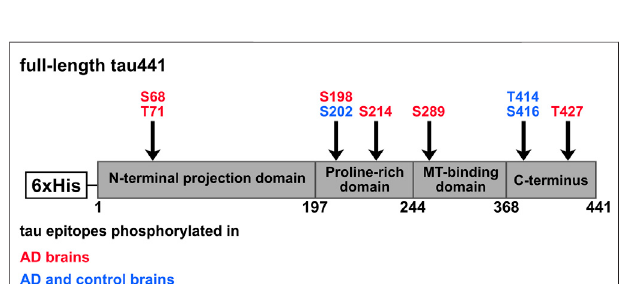
FIGURE 8 | Potential CK1 δ -speci fi c phosphorylation sites on tau protein. Tau441 phosphorylation sites were predicted in silico or detected experimentally via MS analysis, in vitro kinase assay or phosphopeptide analysis. Shown are CK1-speci fi c phosphorylation sites, which were predicted/identi fi ed with at least two methods. Red: Tau epitopes phosphorylated in AD brain. Blue: Tau epitopes phosphorylated in AD and control